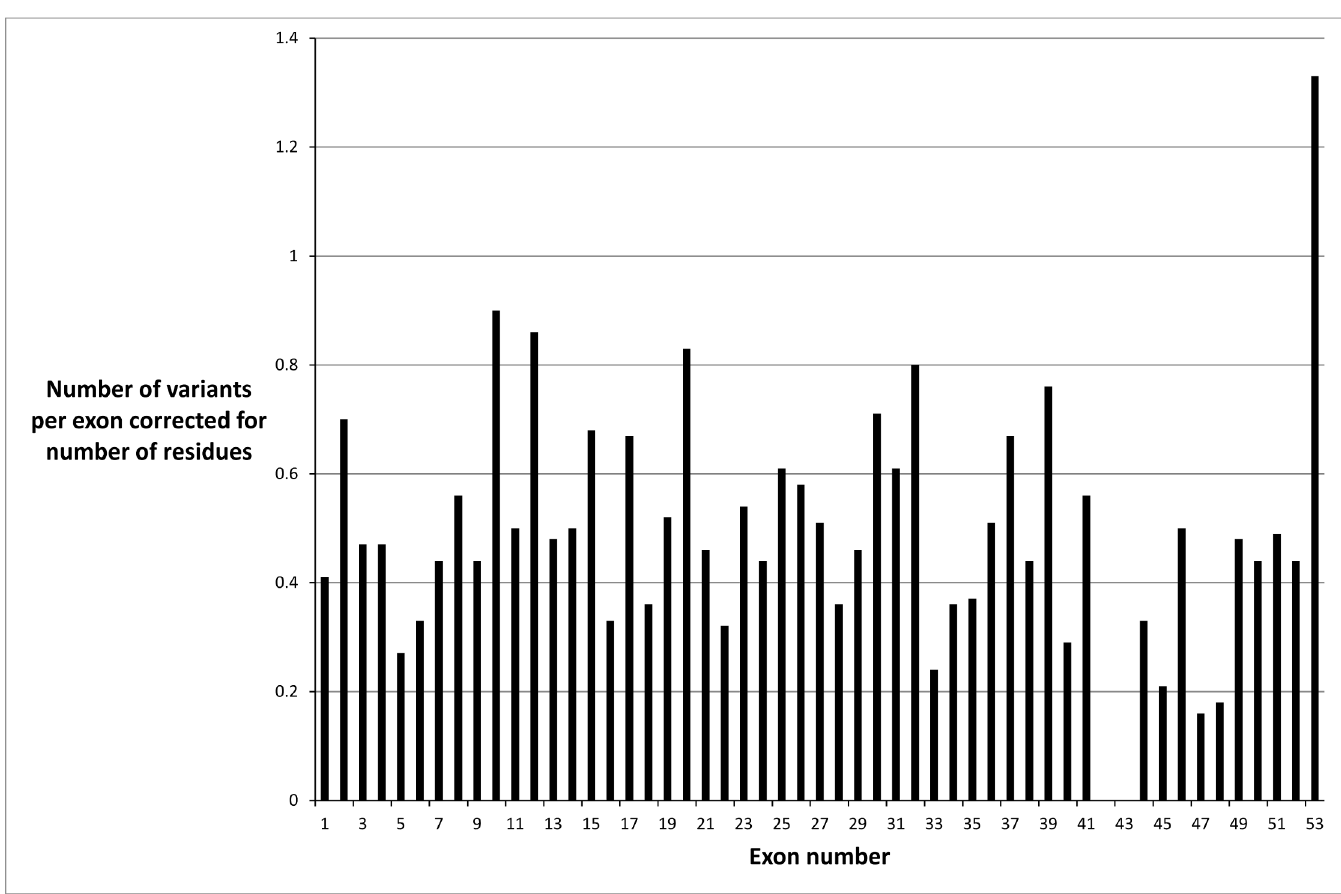
Fig 1. Distribution of missense variants in the COL4A5 gene in each exon corrected for exon size and demonstrating a non-uniform